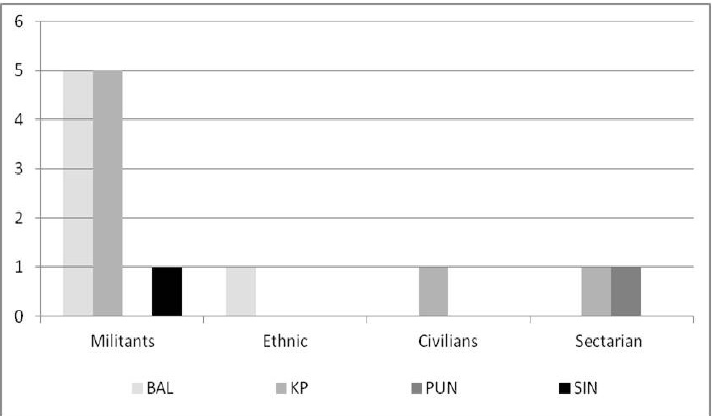
Figure 6. Number of clusters obtained for different Terror Attack–Terrorism Target combinations.